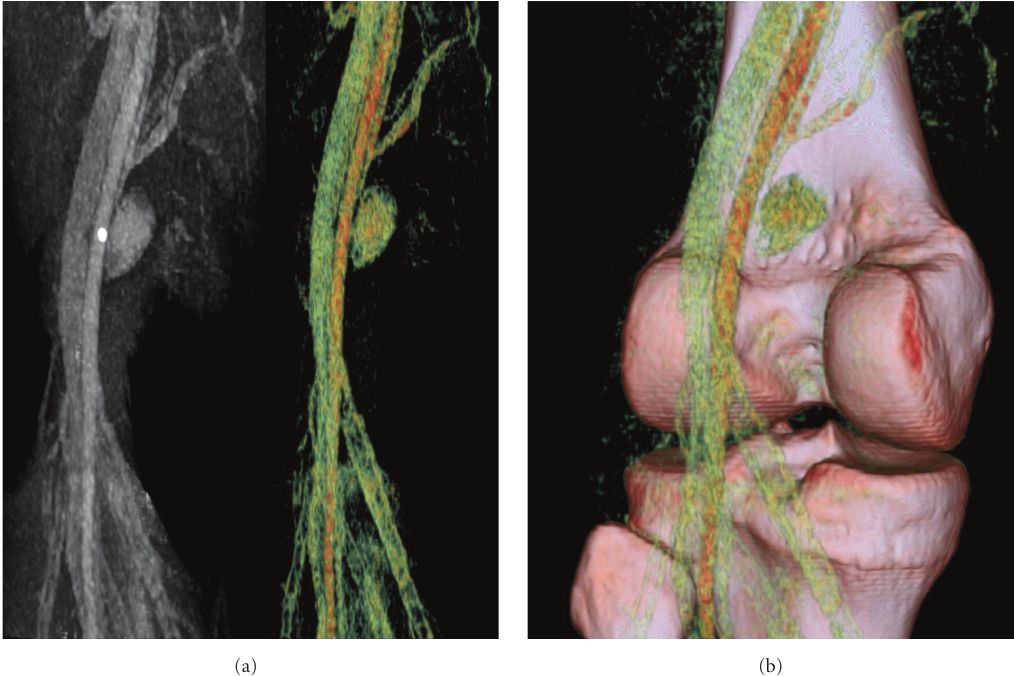
Figure 3: Angio-Computed Tomography (ACT) scan reconstruction using maximal intensity projection (MIP), volume rendering (VR) technique, and 3D showing the popliteal venous aneurysm in the left popliteal